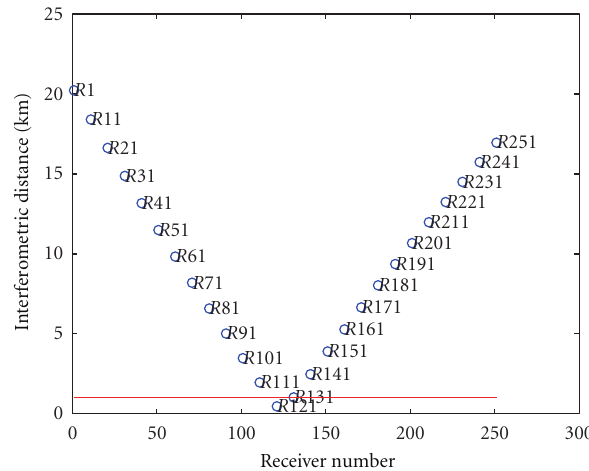
Figure 7: Example of the interferometric distance for di ff erent R R i R i pP . The receiver pPp with the fixed pPp with the interferometric distance less than the threshold value (1km) is defined as the stationary phase pair.